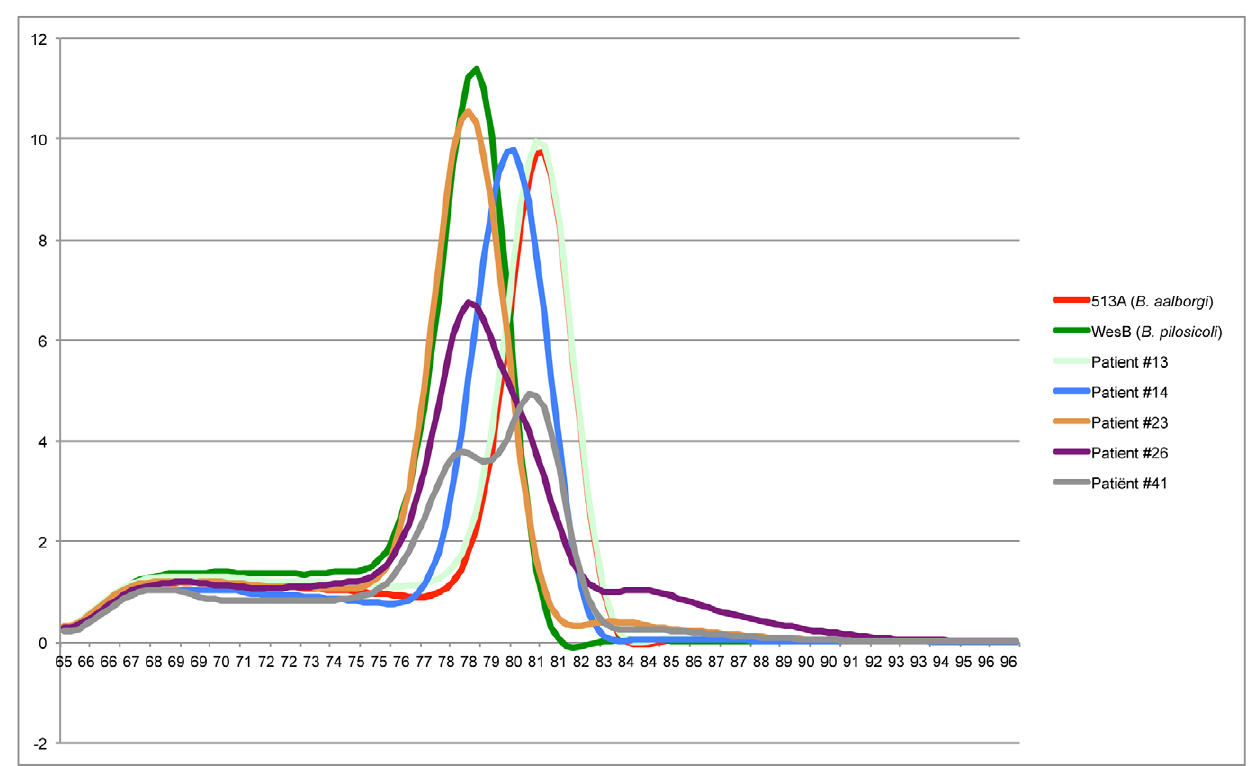
Figure 2. Example of the melting-curve analysis. There is a clear difference in melting-temperature between the type-strain of B. pilosicoli and B. aalborgi . Biopsy samples containing these species fall neatly within these graphs (patients # 13 and # 23). ‘‘B. hominis’’ (patient # 14) is visible as a peak between the type strains, indicating a different base-pair composition. The double infection (patient # 26) begins as a B. pilosicoli -peak with a clear shoulder under the ‘‘B. hominis’’ peak, indicating that two different DNA molecules are present, each with a different melting-temperature- peak. The triple infection (patient # 41) is displayed here by the biopsy sample that had both a B. pilosicoli and a B. aalborgi , another biopsy sample taken from this patient at the same time indicated an infection with ‘‘B. hominis’’ (data not shown).